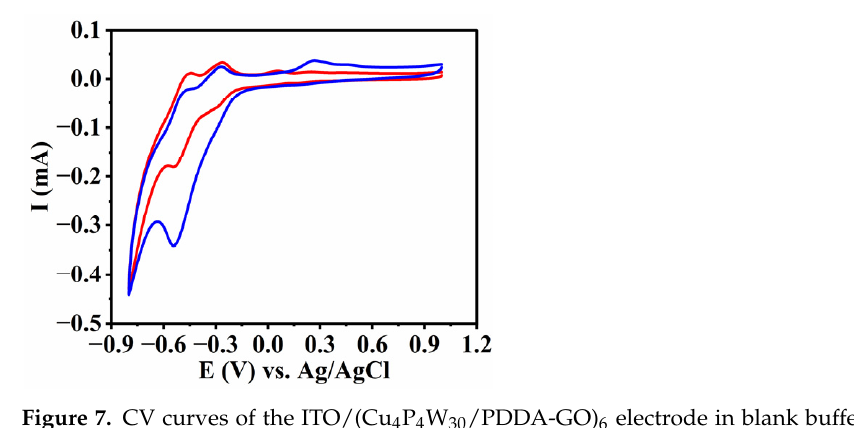
Figure 7. CV curves of the ITO/(Cu 4 P 4 W 30 /PDDA-GO) 6 electrode in blank buffer solution (red curve) and 2,4-DNPH solution (10 µm, blue curve) at pH 3 with scan rate of 50 mV·s − 1 .